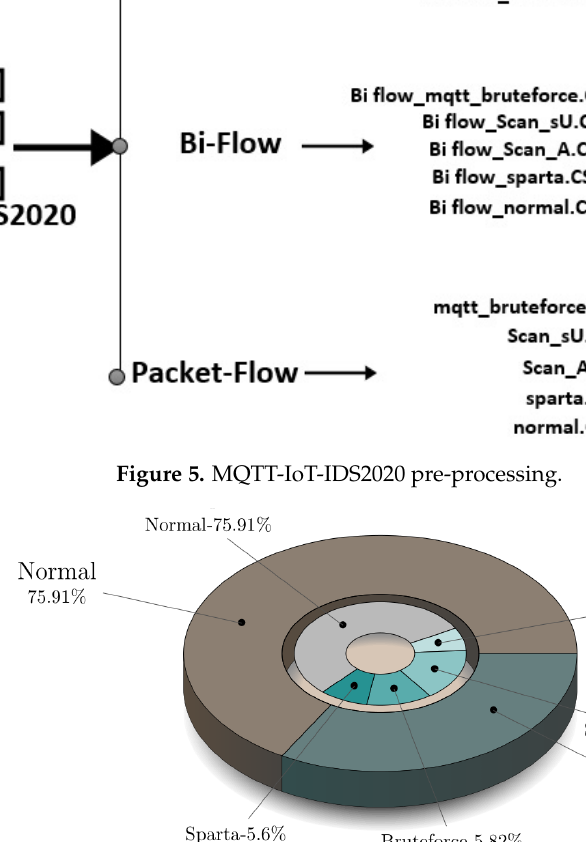
Figure 6. Five files statistics of Uni-flow.